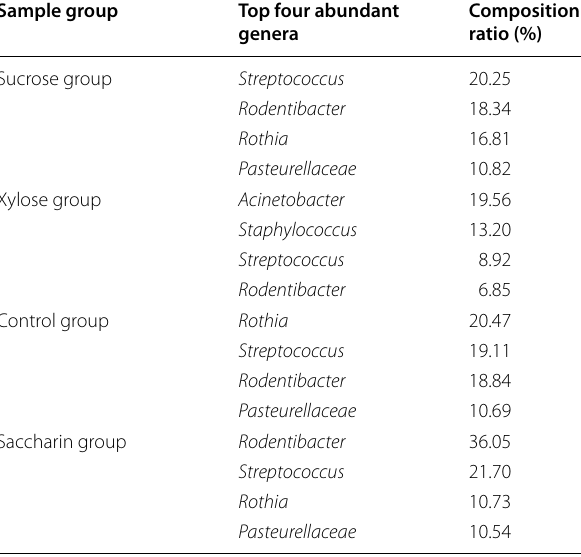
Table 1 The top 4 abundance bacteria genus among the four groups of rats oral microbiota Sample group Top four abundant